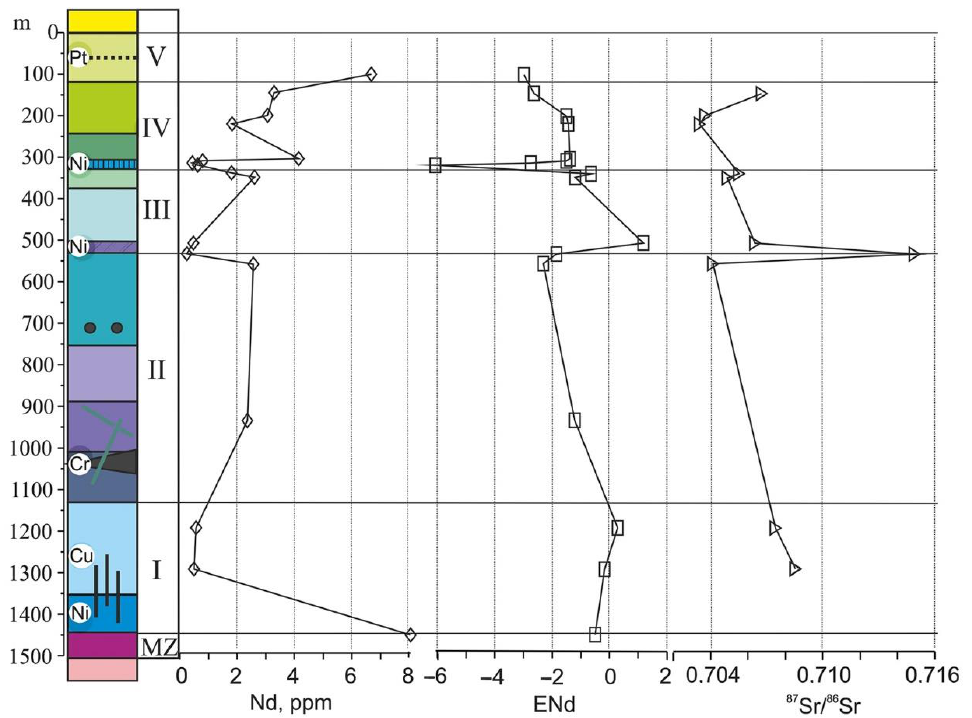
Figure 18. Variations in Nd content and initial ratios of ε Nd, 87 Sr/ 86 Sr in rocks according to the vertical cross-section of the Monchepluton. For the description, see Figure 3.